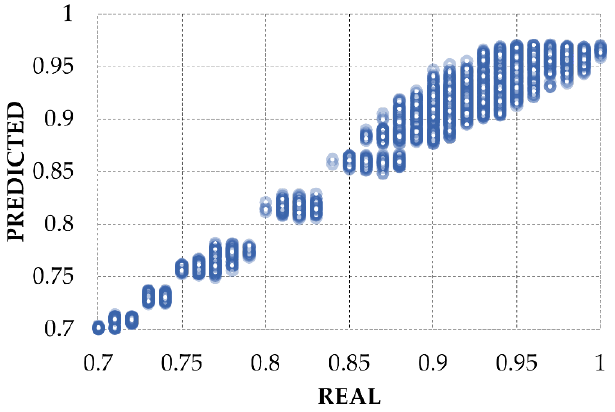
Figure 5. Scatter plot of estimated and real values of operational speed rotation for Network